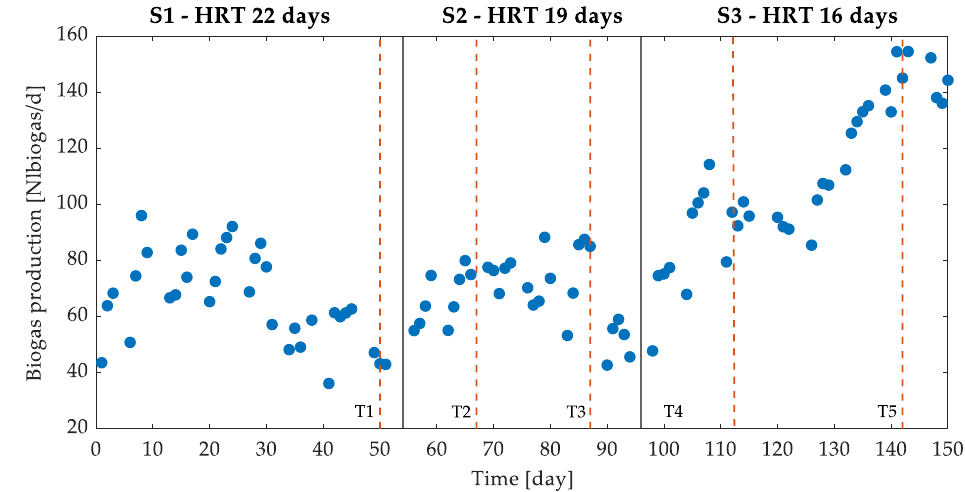
Figure 4. Biogas production during the experimental period. Continuous lines indicate different scenarios, while dashed lines indicate digestate sampling campaigns. Sample T5 was analyzed for bacterial ecology.